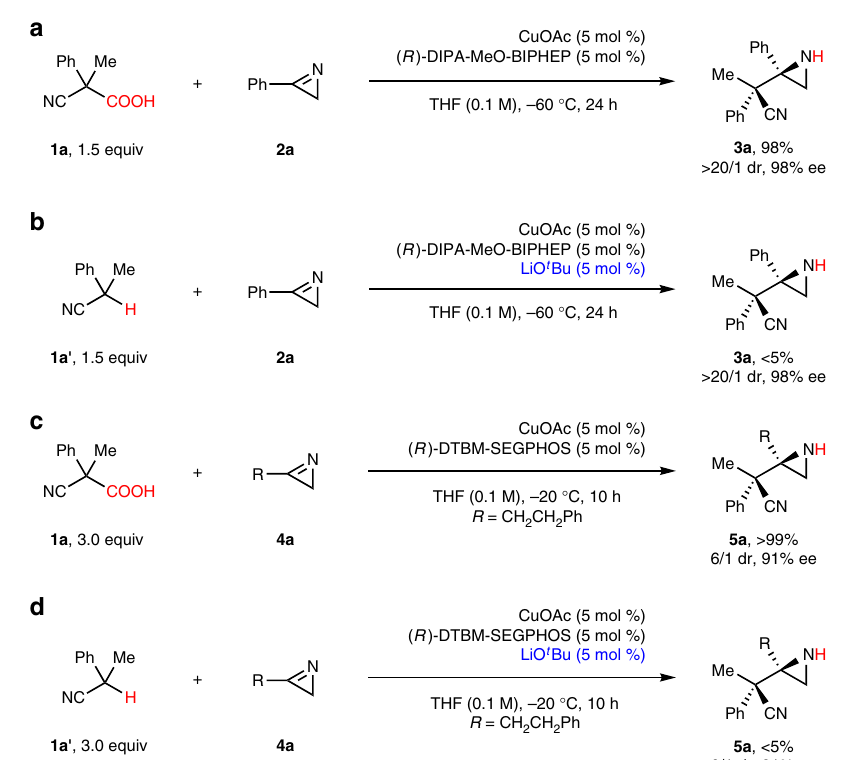
Data availability The X-ray crystallographic coordinates for structures reported in this study have been deposited at the Cambridge Crystallographic Data Centre (CCDC), under deposition number CCDC 1891666 ( 8 ). These data can be obtained free of charge from The Cambridge Crystallographic Data Center via www.ccdc.cam.ac.uk/data_request/cif. The data supporting the fi ndings of this study are available within the article and its